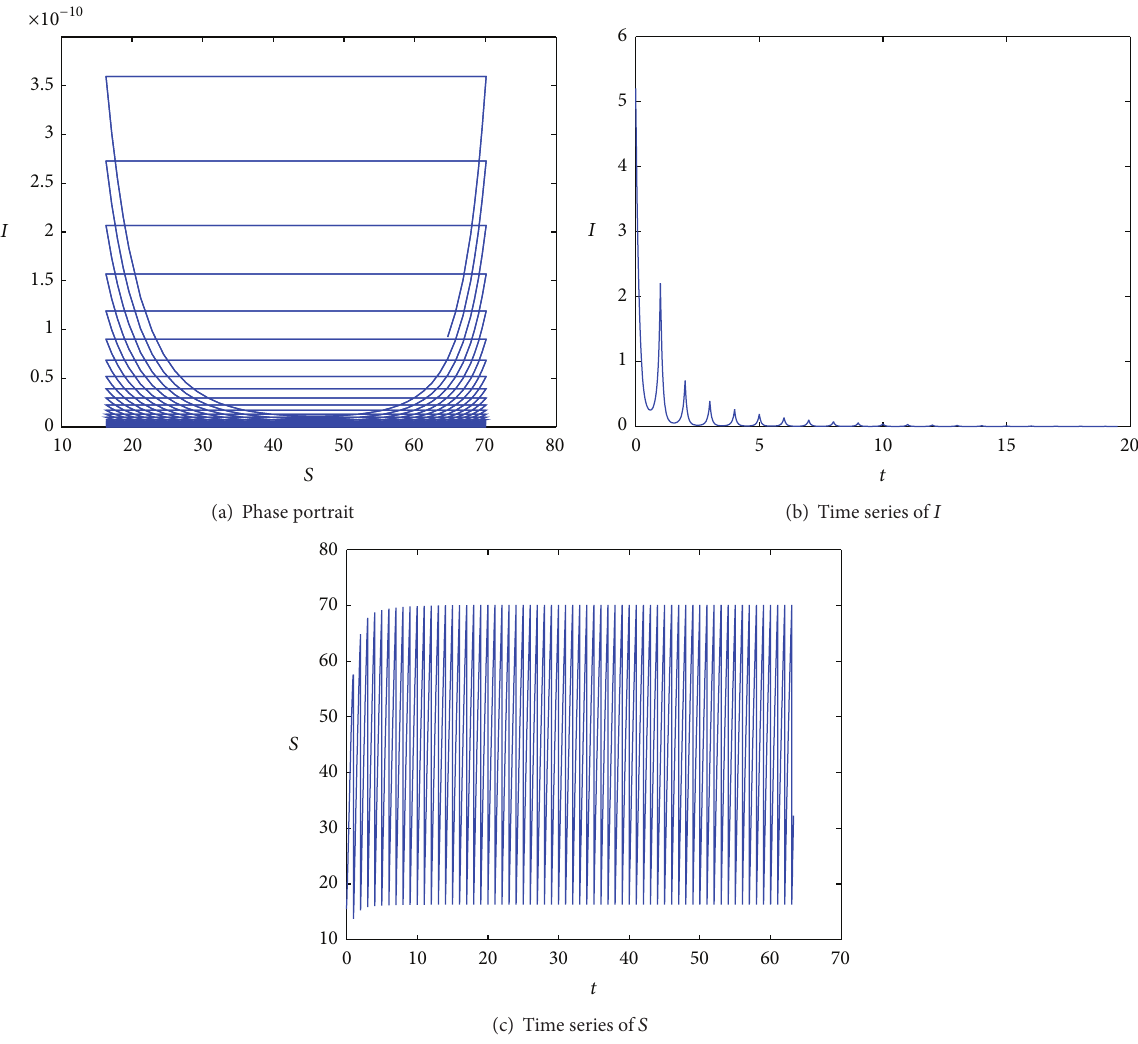
Figure 1: The stable disease-free periodic solution of system (8) with 𝜃 = 3 .